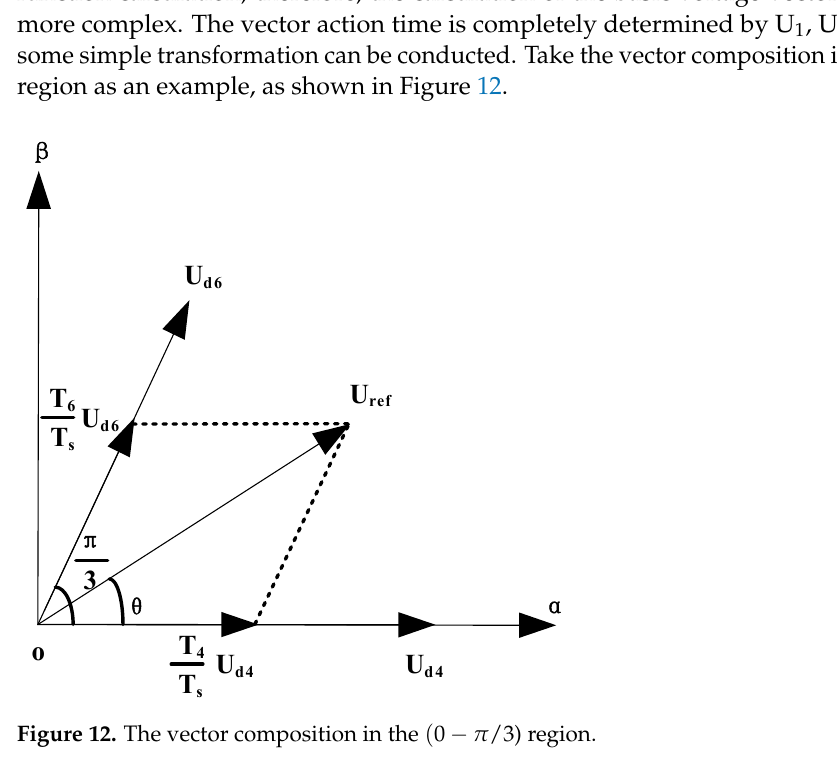
Table 6. Corresponding relationship of sector, basic vector, αβ coordinate system region order, and RAM.